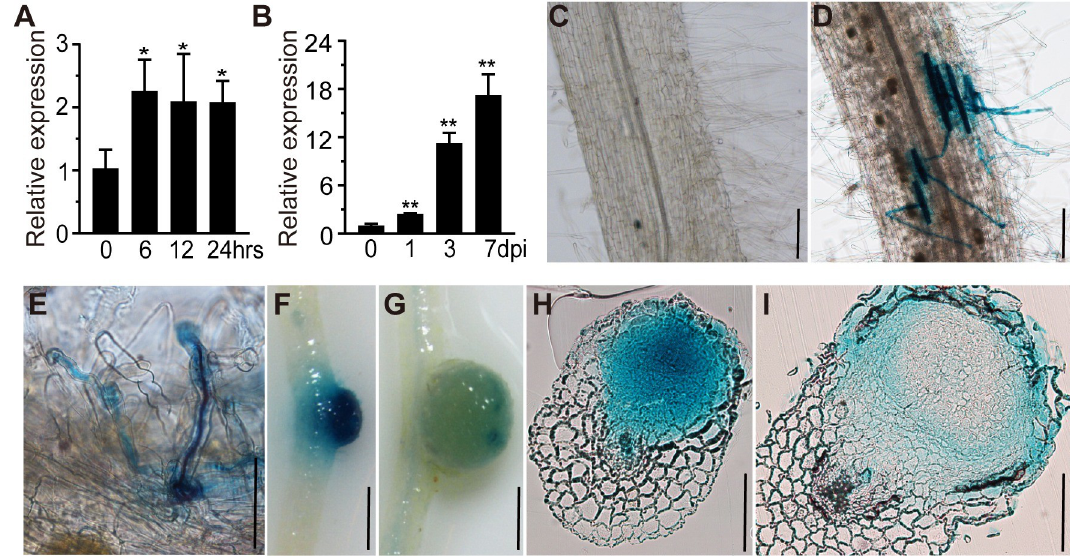
Fig 2. RPG expression pattern in L . japonicus roots. (A-B) qRT-PCR analysis of RPG transcript levels in roots of wild type (WT) L . japonicus . Samples were collected at 0, 6, 12, and 24 h after inoculation with purified Nod factor (A) or at 0, 1, 3 and 7 days after inoculation with M . loti R7A (B). Expression is relative to that of mock-treated samples (0 h or 0 dpi) and normalized to L . japonicus Ubiquitin . Asterisks indicate significant differences between the mock and the rhizobial/Nod factor treatments at the indicated time points by Students t -test. (C-G) p RPG : GUS expression patterns in L . japonicus roots and nodules. The constructs were expressed in wild type and the transgenic roots were stained with X-Gluc (blue). No GUS was detected in the absence of rhizobia inoculation (C). Strong GUS staining was detected in epidermal cells (D) and (E) and young nodules (F), but there was much lower staining in mature nodules (G). Bacteria were stained by magenta (purple) to indicate ITs (E). (H-I) Nodule sections showed that pRPG : GUS expressed in all cell layers of young nodules (H), but was only expressed in epidermal and nodule parenchyma cells in mature nodules (I). Scale bars: 100 μ m (C-E and H-I); 1 mm